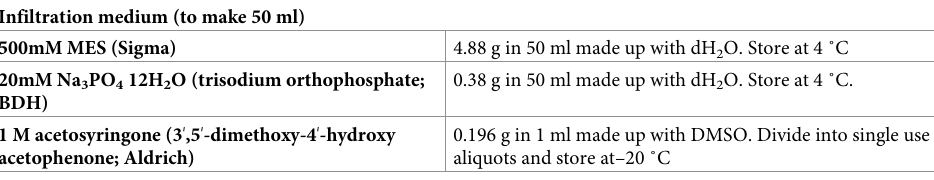
Table 1. Composition of reagents to make 50 mL of infiltration